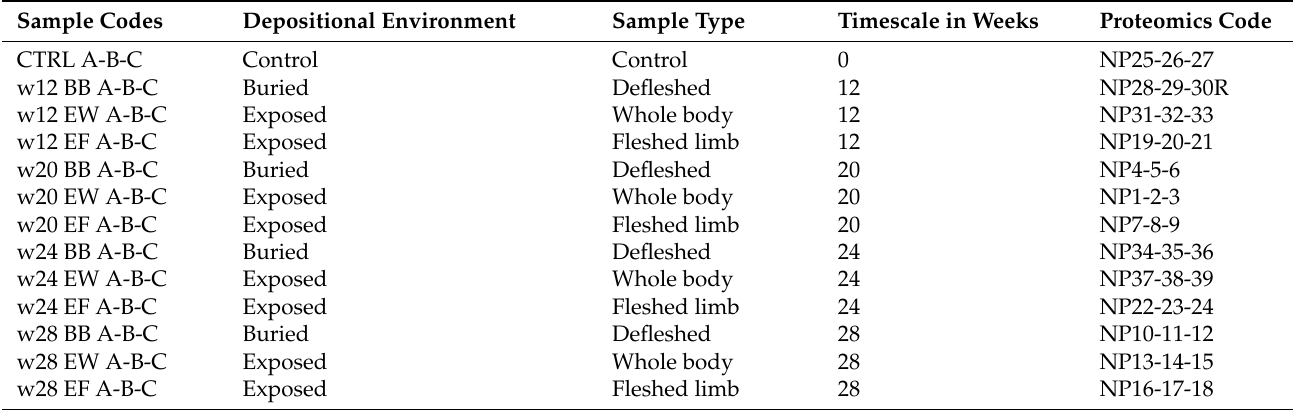
Table 1. Samples used for proteomics, with the sample codes, depositional environment, sample type, post-mortem timescale, and proteomics code associated with